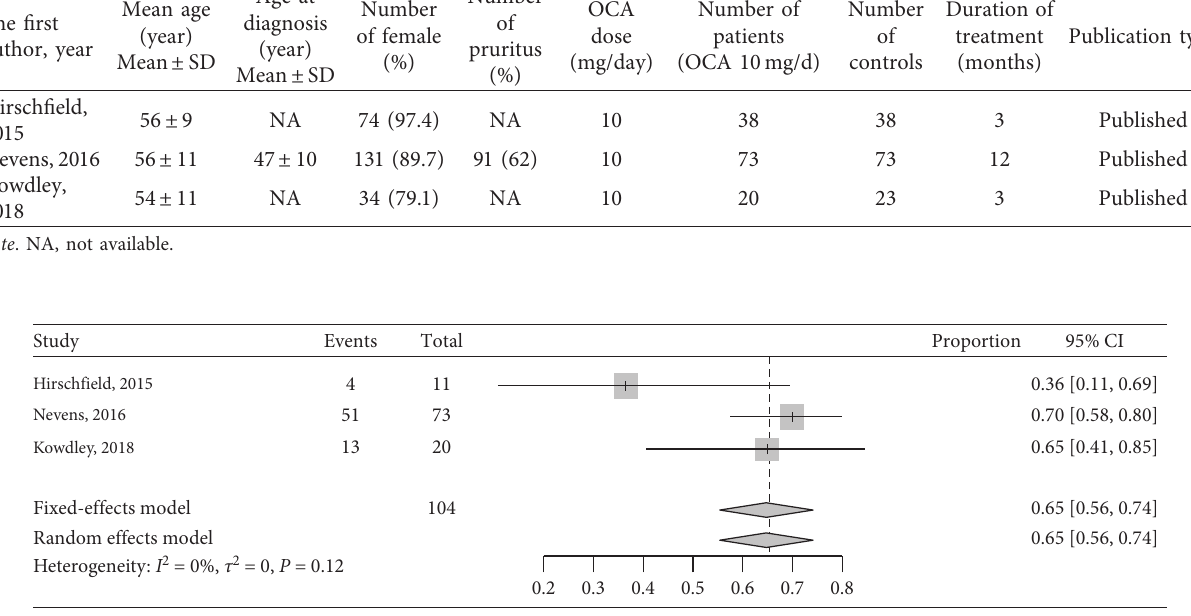
Figure 4: The pooled overall complete response rate in patients with PBC treated with OCA 10mg/d monotherapy or added to UDCA according to the Paris I criteria.